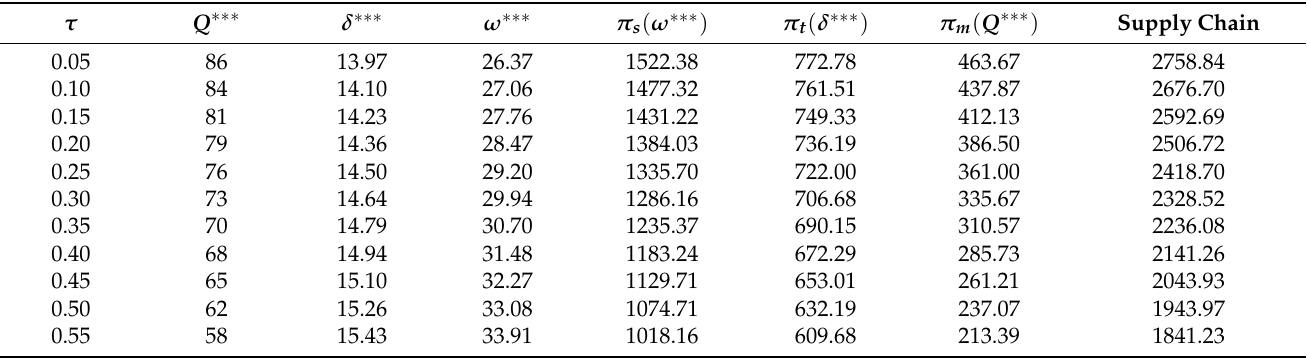
Table 3. Influences of transportation cost sharing on decision variables and profits.